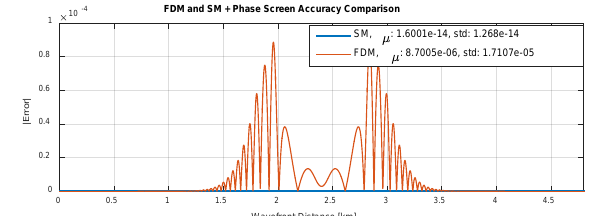
Figure 5. Gaussian Lens FDM and SM Error comparison